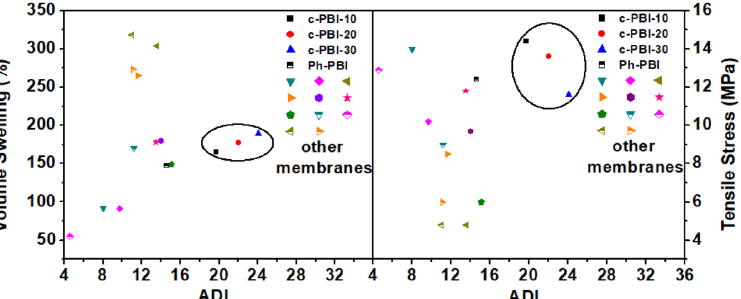
Figure 3. The effects of cross-linking on the mechanical strength and dimensional stability (taken from Ref. [65]).